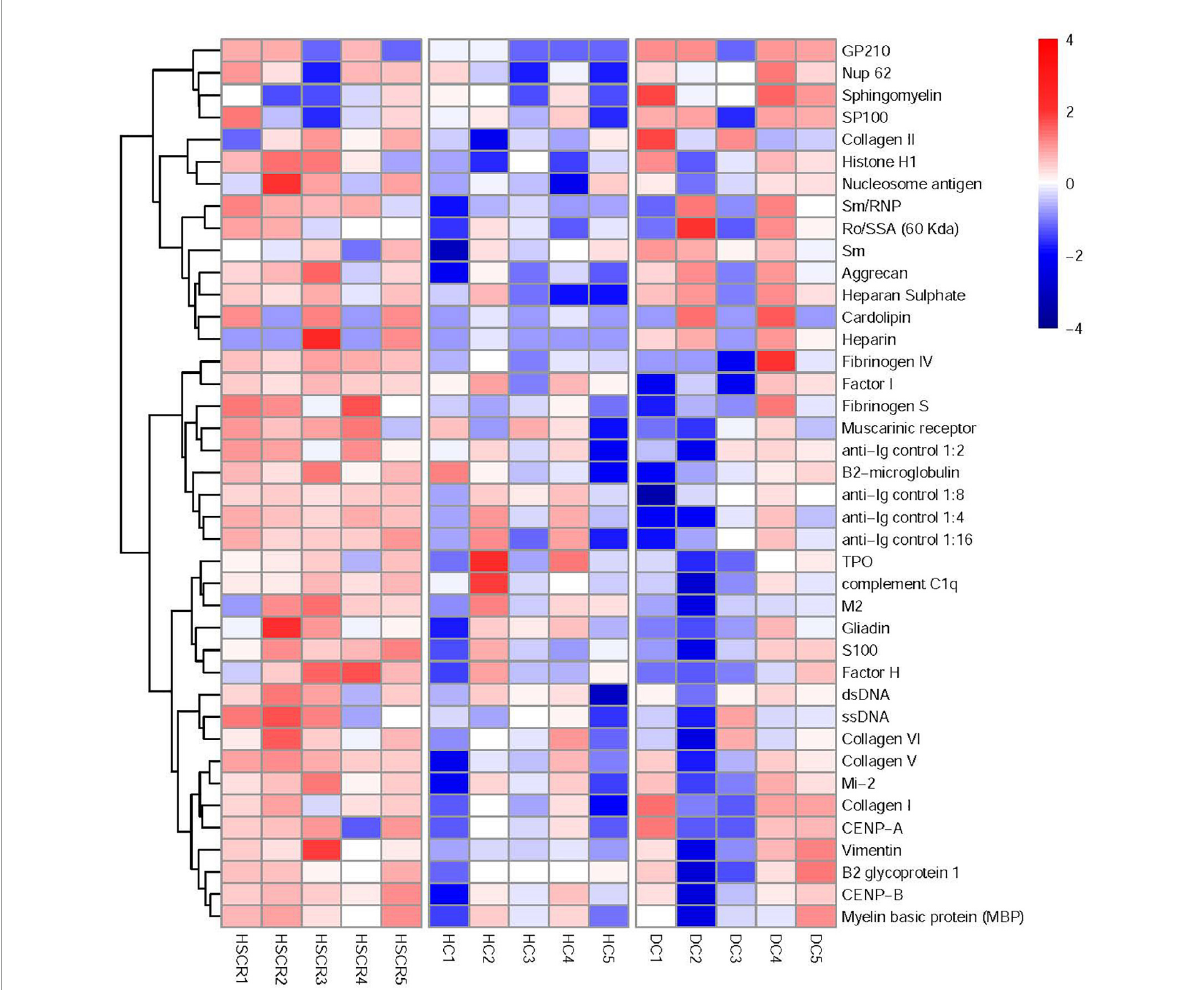
FIGURE1 Screening of human autoimmune antigen microarray and analysis of differential autoantibodies. The robust linear model (RLM) method was used for normalization and M statistics for screening, and then the screening results of the human autoimmune antigen microarray were subjected to cluster